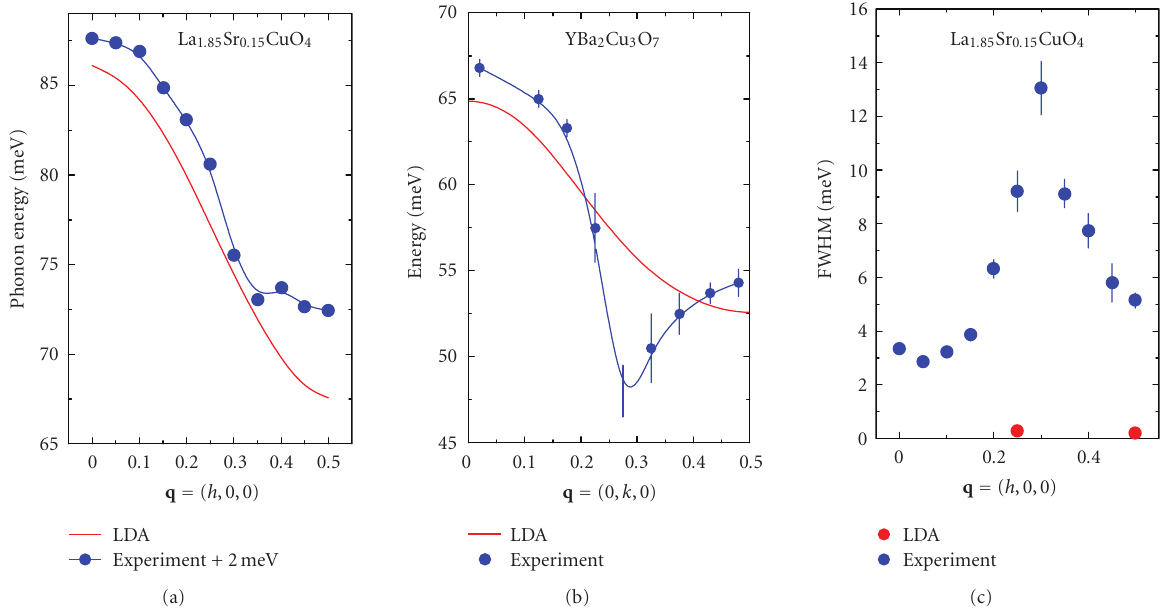
Figure 16: Comparison of some LDA predictions with experimental results for La 1 . 85 Sr 0 . 15 CuO 4 [42] and YBa 2 Cu 3 O 7 [72] at 10 K. (a,b) Experimental bond-stretching phonon dispersions compared to LDA results. The data in (a) are shifted by 2 meV. (c) Phonon linewidths in La 1 . 85 Sr 0 . 15 CuO 4 compared with LDA results on YBa 2 Cu 3 O 7 [42], contains no linewidth results for La 1 . 85 Sr 0 . 15 CuO 4 but they should be